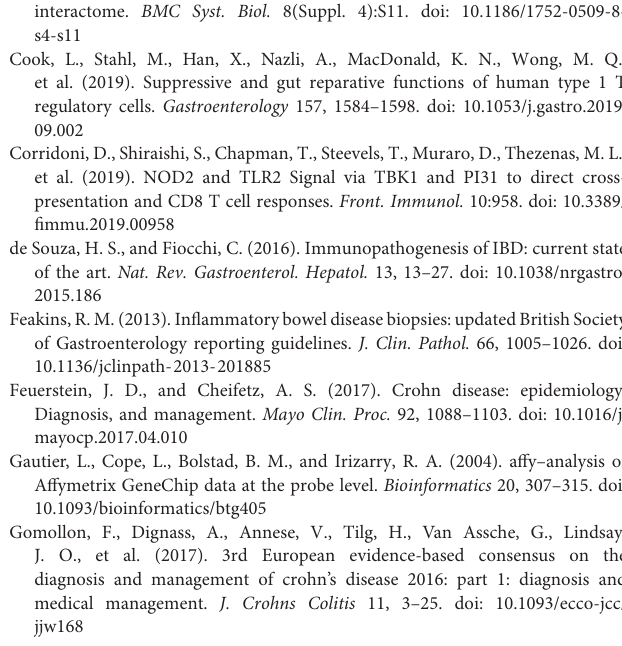
FIGURE S1 | The heatmap of DEGs from derivation cohort. FIGURE S2 | The heatmap of GSVA results from derivation cohort. FIGURE S3 | Data preprocessing of the validation cohort. Box plot and principal component analysis showing the overall profiles of GSE3365, GSE10616, GSE16879, and GSE102133 (A,B) before and (C,D) after normalization. The results confirmed removal of the batch effect. FIGURE S4 | The heatmap of DEGs from validation cohort. FIGURE S5 | Boxplot of comparisons of immune-cell proportion between CD patients and healthy controls in the validation cohort. FIGURE S6 | Pearson plot of the model from derivation cohort (A) and validation cohort (B) . TABLE S1 | The results of CIBERSORTx in Crohn’s disease. TABLE S2 | The results of CIBERSORTx in normal control. TABLE S3 | The correlation coefficients of co-expression patterns in derivation cohort. TABLE S4 | The correlation P -value of co-expression patterns in derivation cohort. DATA SHEET S1 | The R code used in our